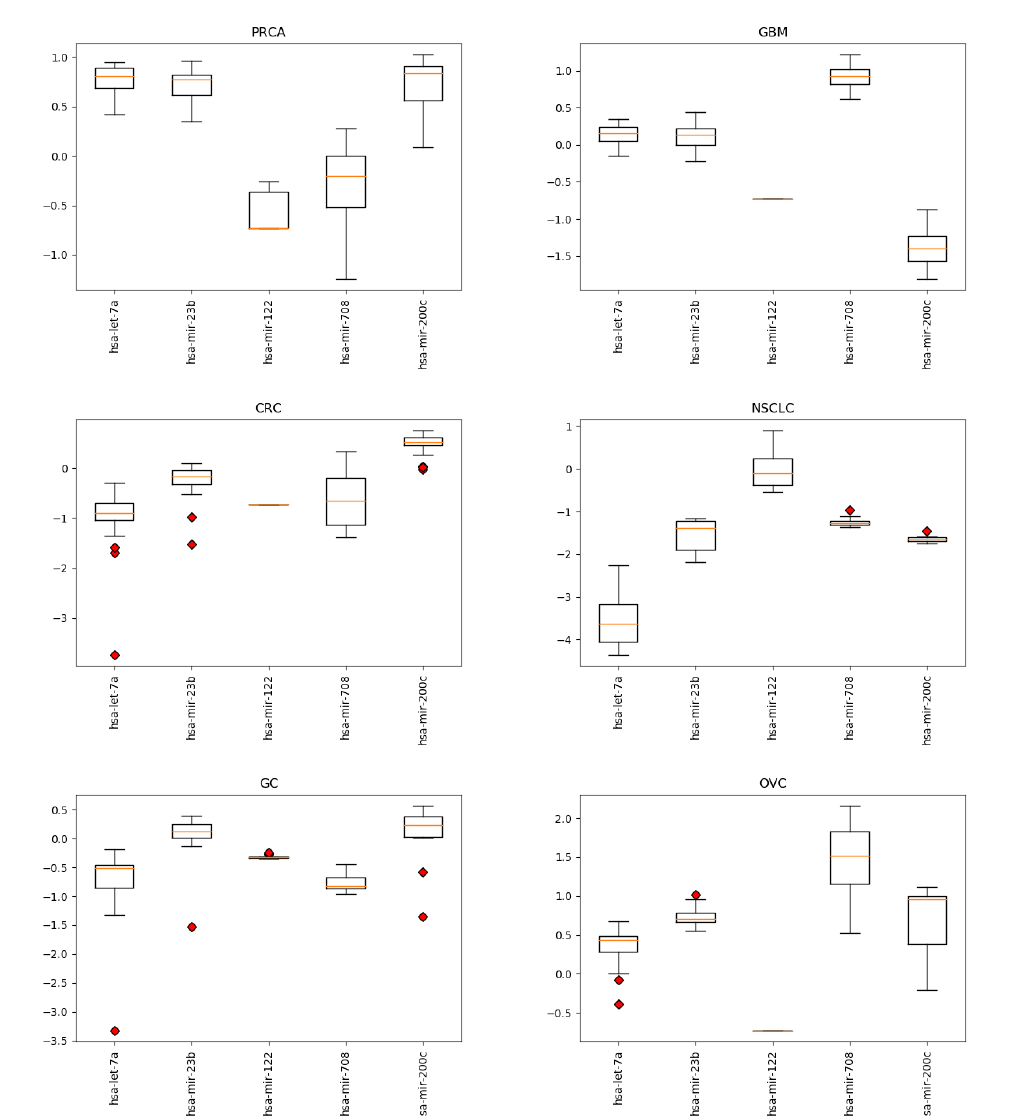
Figure A1. Expression levels by cancer type for the 5 miRNAs identified by the proposed